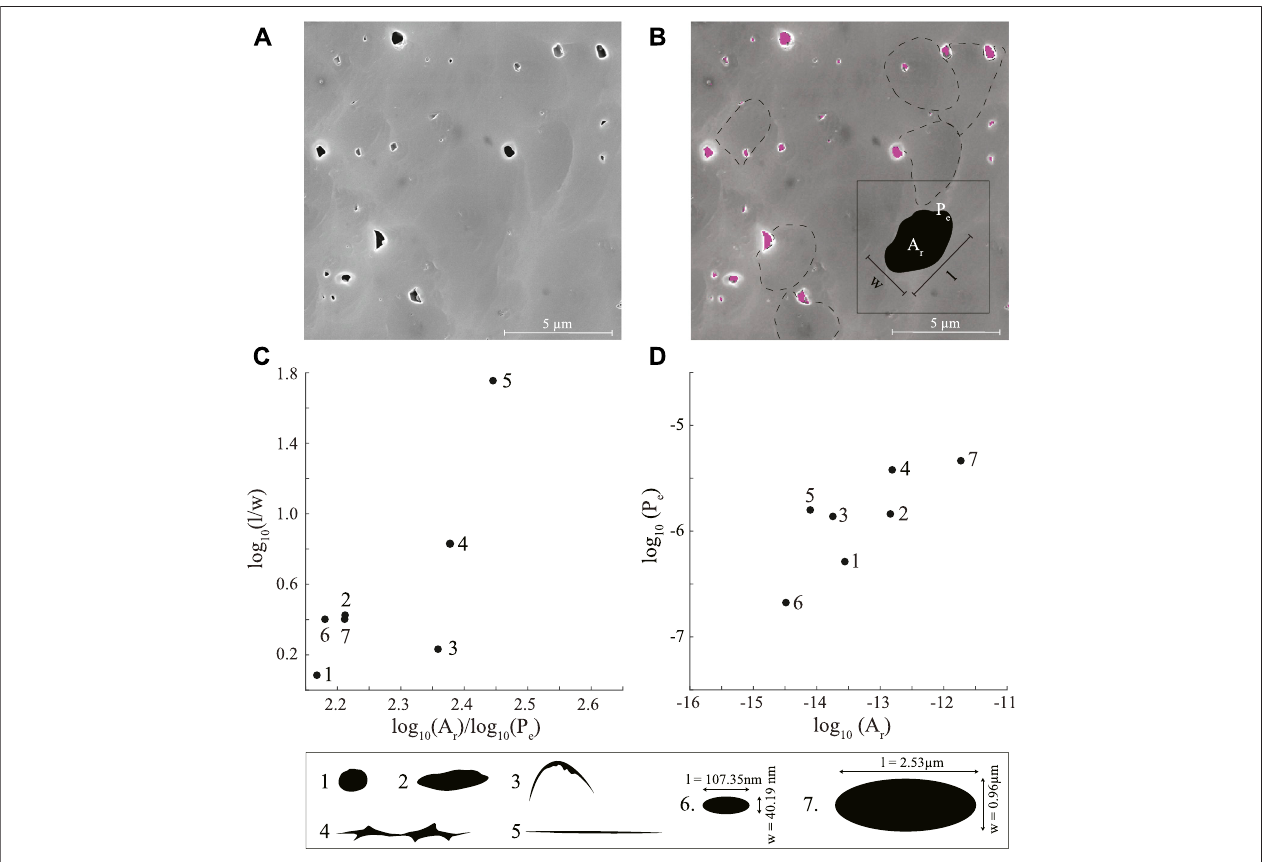
FIGURE 3 | Digital Image Analysis (DIA). (A) Representative SEM photomicrograph, (B) same as (A) showing pores identi fi ed by DIA in solid color and grain boundariesindashed line.Insetshows the cartoonofapore and its architecturalparameters,length [l],width [w], area[A r ] and perimeter [P e ],thatare measured byDIA, (C) log 10 (A r )/log 10 (P e ) vs. log 10 (l/w), and (D) log 10 (A r ) vs. log 10 (P e ) crossplots for pores of different shapes and sizes numbered 1 – 7 shown in the lowest panel. Note that shapes are better resolved in (C) while sizes are better resolved in (D)